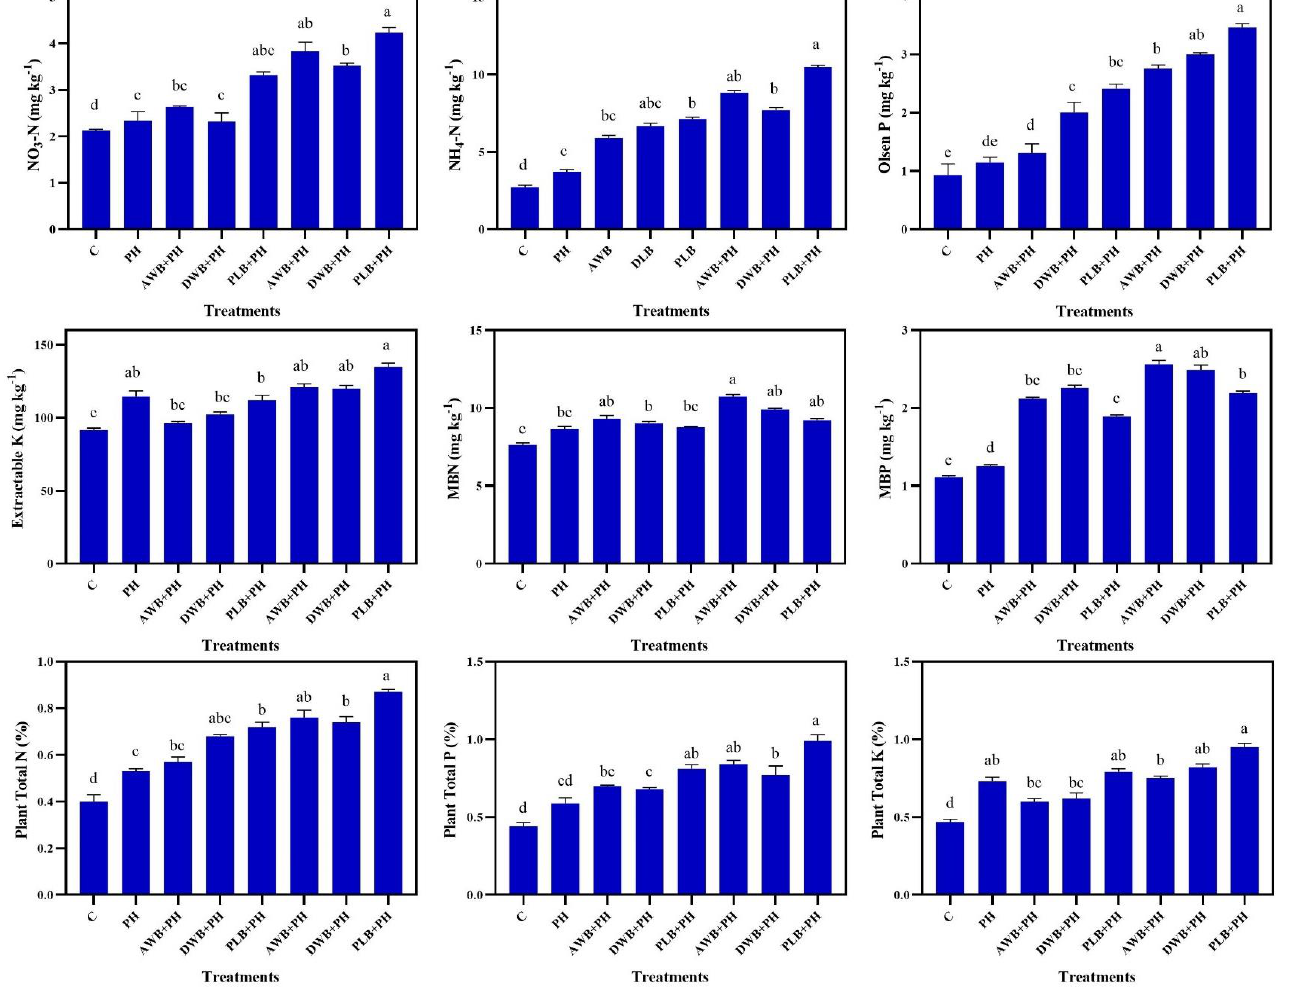
Figure 1. Macronutrient concentrations in soil and plants under each treatment. Values represent the mean with three replications. Treatment abbreviations can be found in Table 1. The small letters on the bars indicate significant differences among treatments at 5% probability levels, where significance was tested by using the multiple comparison LSD test. Error bars indicate the standard error of the mean (n = 3).